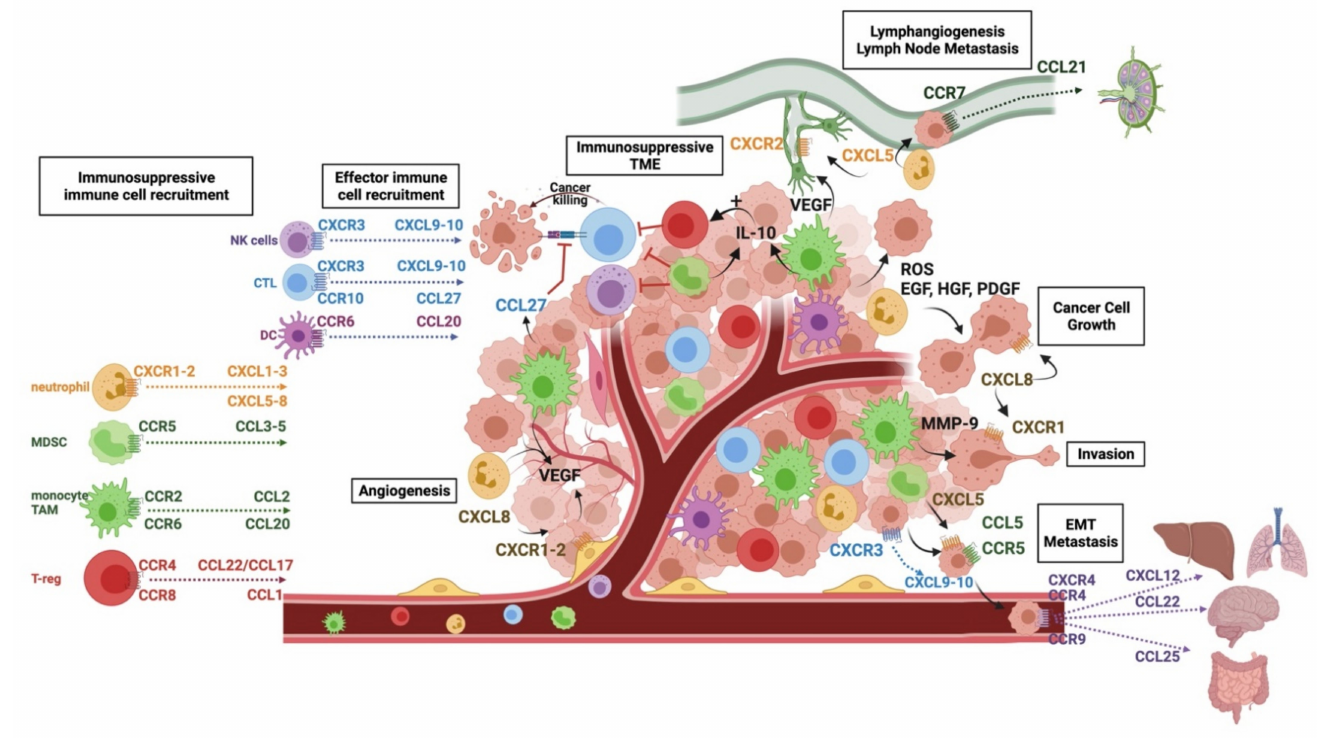
Figure 1. Chemokine networks in cutaneous melanoma. Immune cells are recruited via the networks outlined on the left of the figure. Chemokines enable an immunosuppressive microenvironment (TME) to be created via the preferential recruitment of immunosuppressive cells such as MDSCs, TAMs, and T-regs, which reduce the T-cell effector function and enhance the further recruitment and expansion of immunosuppressive cells. Cancer growth, invasion, and angiogenesis are promoted by the factors secreted by cells recruited to the TME via chemokines such as neutrophils and TAMs, as well as directly via CXCL8; lymphangiogenesis and lymph node metastasis are enabled through CXCL5/CXCR1-2 signalling, and cancer cells are able to migrate to lymph nodes using the CCL21/CCR7 pathway. EMT-like processes are enabled through CCL5 and CXCL5 signalling through their respective receptors. Transendothelial migration is promoted via the CXCL9- 10/CXCR3 pathways, and cancer cells are able to move to specific sites using chemokine networks, e.g., CCL25/CCR9 to the gut, CCL22/CCR4 to the brain, and CXCL12 CXCR4 to the liver and